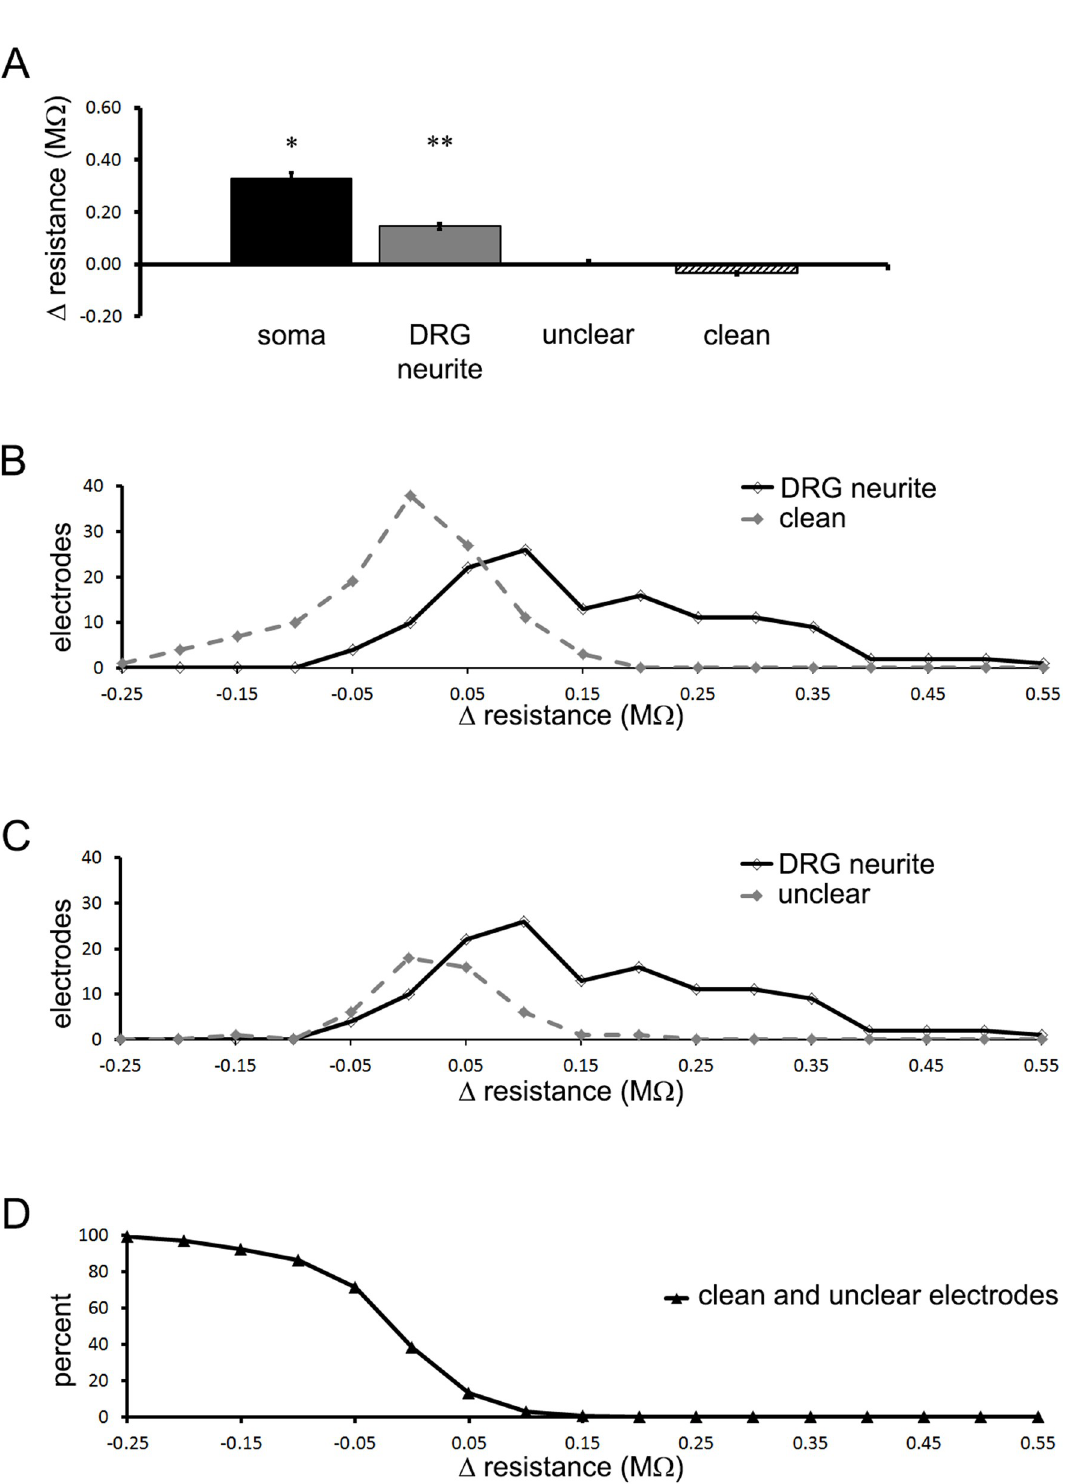
Fig 3. A criterion of 0.15 M Ω relative to CLEAN electrodes would predict with 100% accuracyelectrodes contacted by a DRG process. (A) Resistance values backgroundsubtracted to UNCLEARelectrodeswithin experiments